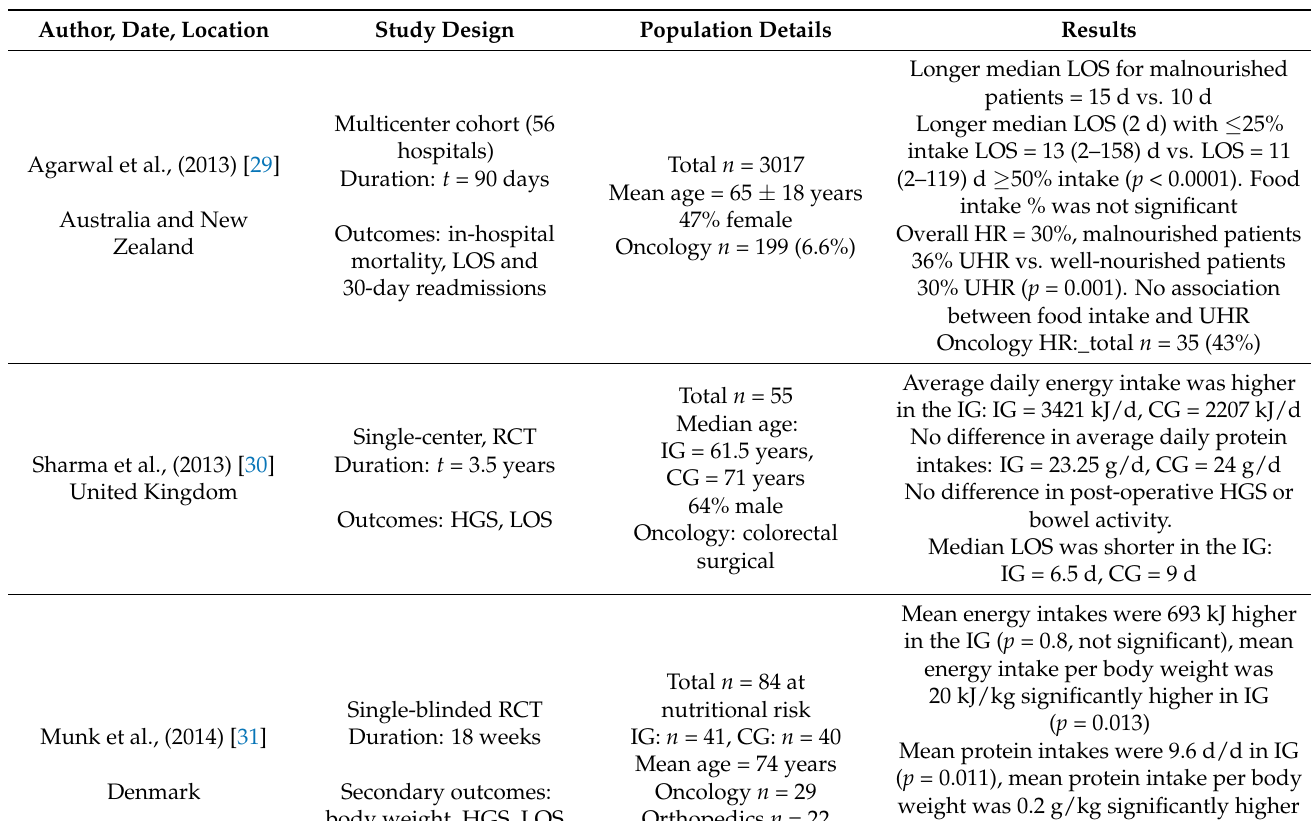
Table 1. Findings from included studies reporting relationships between dietary intakes and relevant clinical